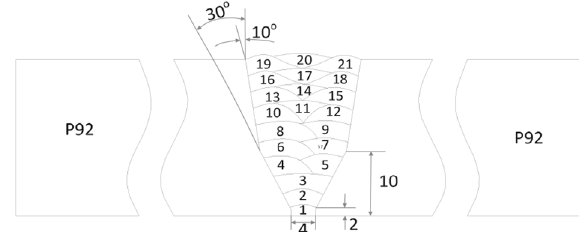
Figure 4: Dimensions of groove and welding sequences.